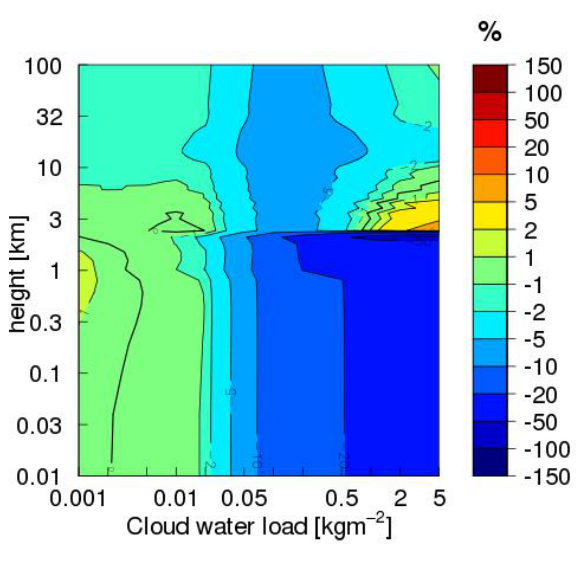
Figure 11. As for Fig. 2 but for varying cloud water load and IFS- Fouquart vs. HS-DISORT (experiment 4).